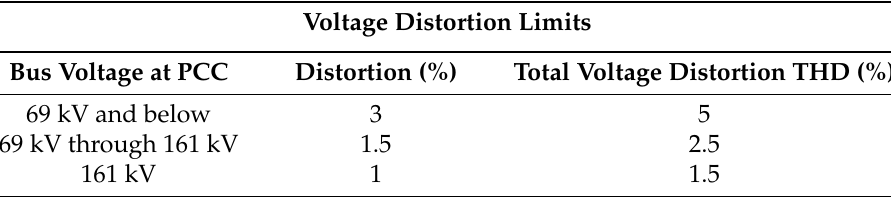
Table 1. IEEE Std 519-1992 harmonic voltage